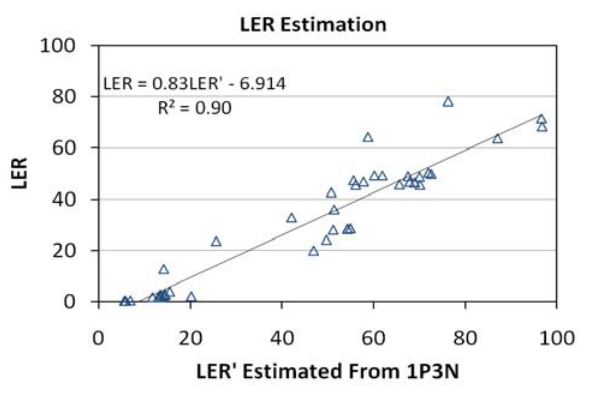
Figure 22. LER versus estimated LER from TM1, photopic, TM3 and NIR